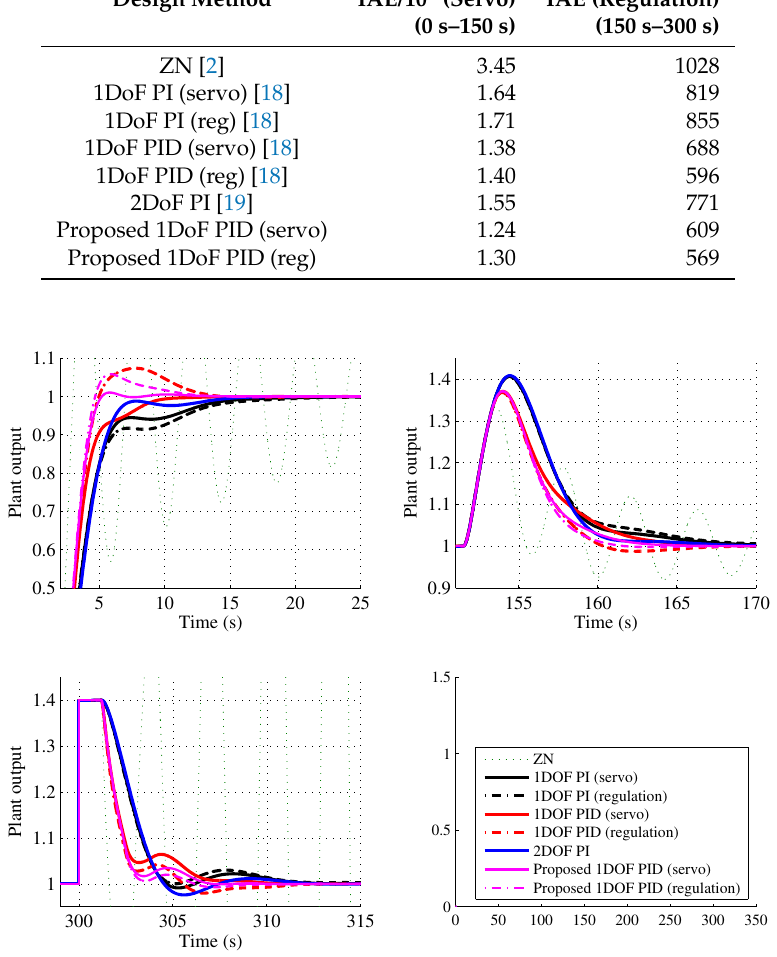
Figure 17. Enlarged views of Figure